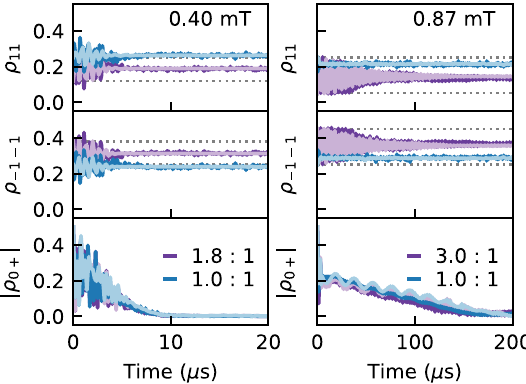
FIG. 13. Density matrix elements of the kh -V C V Si divacancy for a nuclear configuration containing a strongly coupled nuclear spin with A iz = 8.93 MHz at low magnetic fields. The color indi- cates the ratio of | a | and | b | in the initial |+(cid:2) = a |− 1 z (cid:2) + b |+ 1 z (cid:2) state of the qubit. In each case, the qubit is initially prepared in √ 2 )( |+(cid:2) + | 0 (cid:2) ) . The lines with brighter color the state | ψ (cid:2) = ( 1 / correspond to the exact solution with the same initial state for a smaller bath (nine nuclear spins). The dotted gray line corre- sponds to the initial value of the density matrix diagonal element. We set ρ 00 = 0 for all calculations.